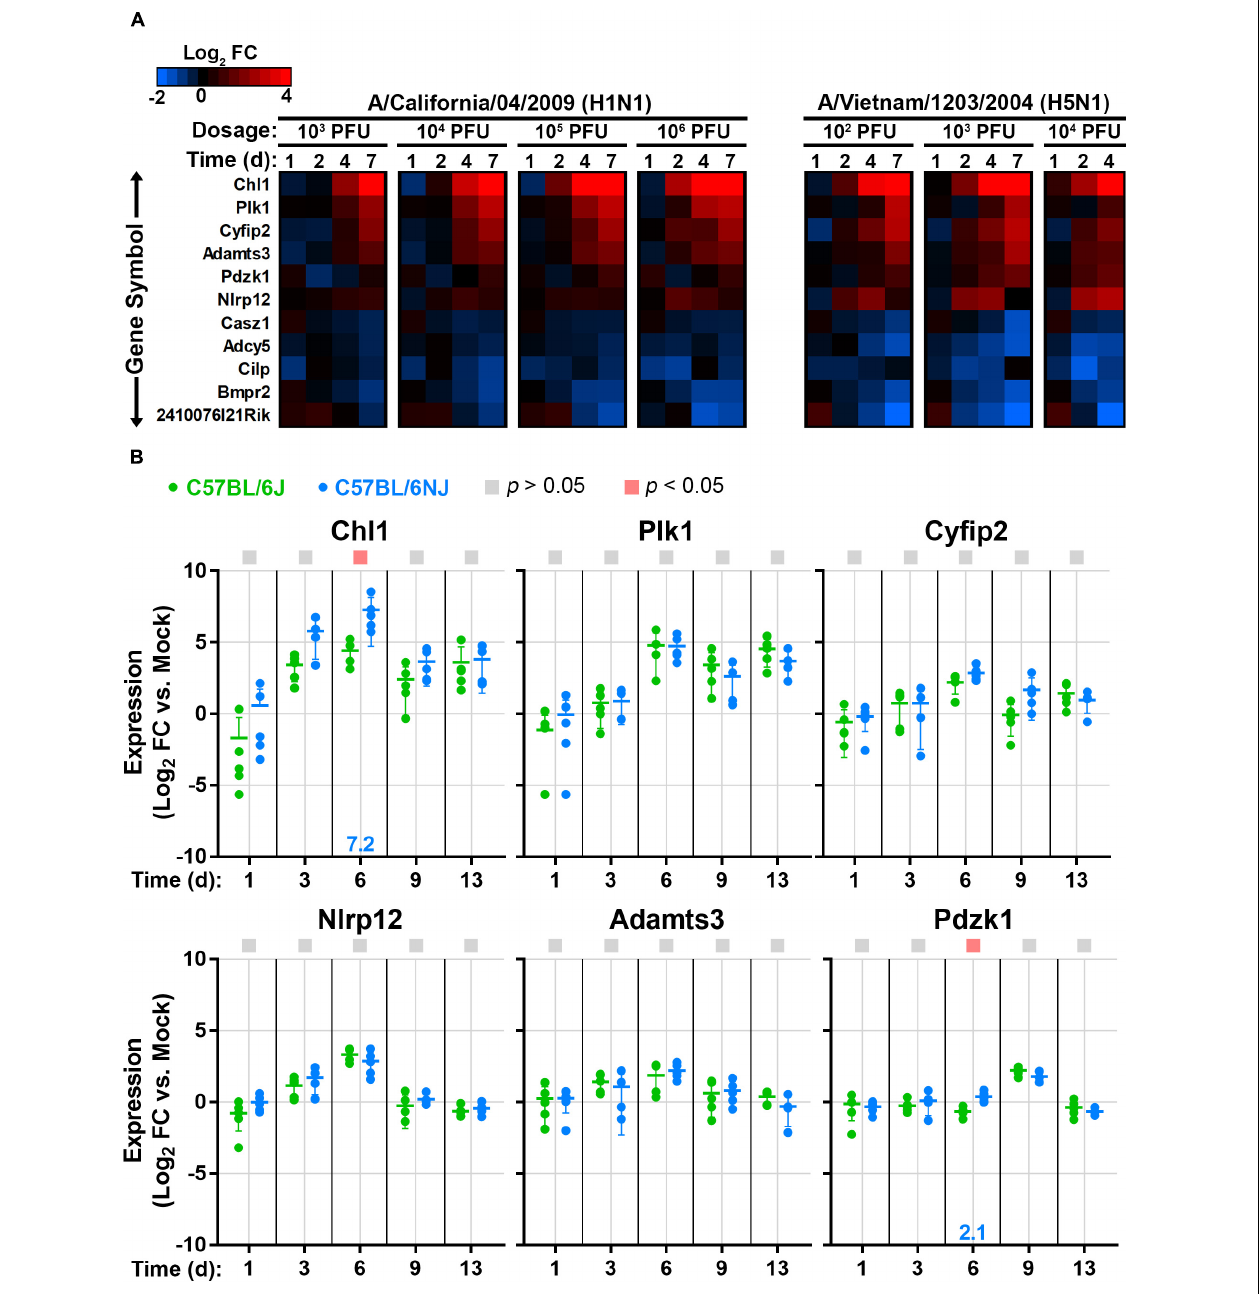
FIGURE 7 | Lung expression of host genes that vary between C57BL/6J and C57BL/6NJ mice after influenza infection. (A) The heat map shows host genes that are differentially expressed (fold change > 1.5, false discovery rate-adjusted p -value < 0.05) in at least one dosage and time point for both CA04 and VN1203, as determined from previously published microarray analysis of C57BL/6J mouse lung tissue (GSE33263 and GSE37569) (McDermott et al., 2011; Tchitchek et al., 2013). (B) For the six host genes that were up-regulated in C57BL/6J mouse lungs in (A) , relative RNA quantities were determined in C57BL/6J and C57BL/6NJ by using qPCR with the comparative threshold cycle method, with the mouse Tbp gene serving as the endogenous reference and mock-infected samples serving as the calibrators. Group means are shown by horizontal bars, and error bars indicate standard deviation. Statistical significance and the associated fold-changes are reported as described for Figure 5